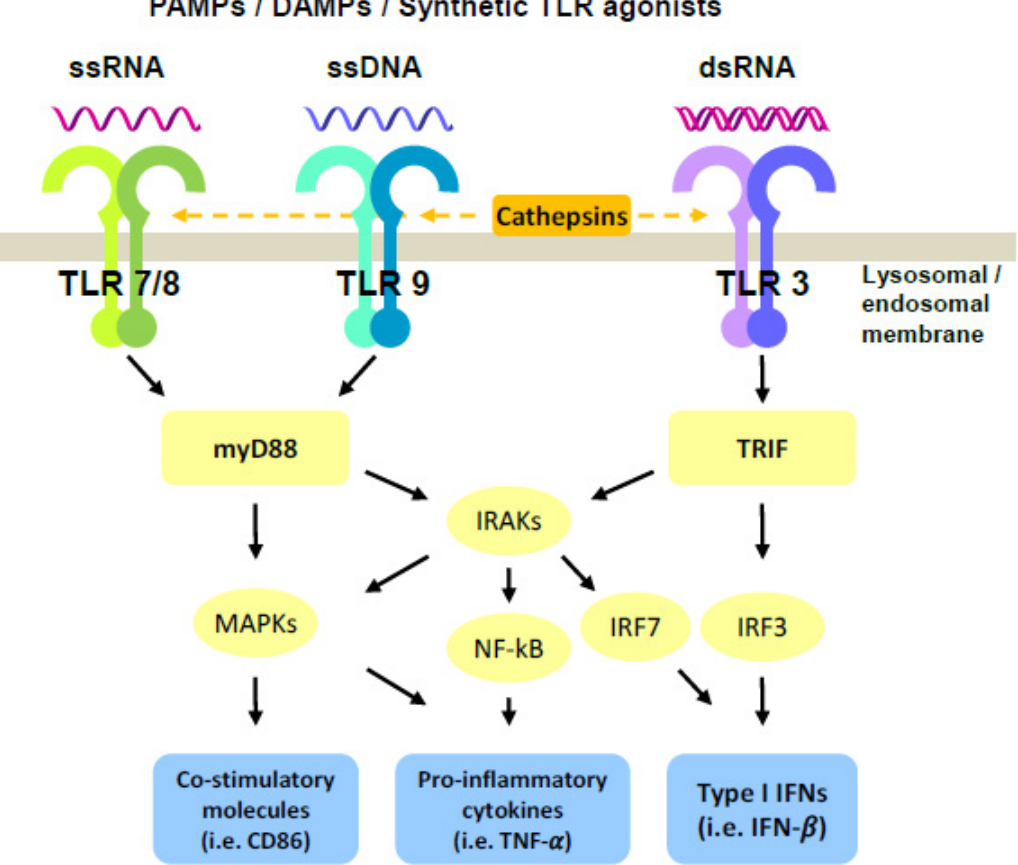
Figure 1. Schematic representation of endosomal TLR activation pathways. Upon ligation of en- dosomal TLRs, stimulation of myD88 or TRIF signaling results in the activation of co-stimulatory molecules, secretion of pro-inflammatory cytokines and Type I IFNs responses. Furthermore, com- bination treatment with TLR agonists triggers a synergistic induction of NF-kB, IRFs, or MAPKs pathways, leading to enhanced